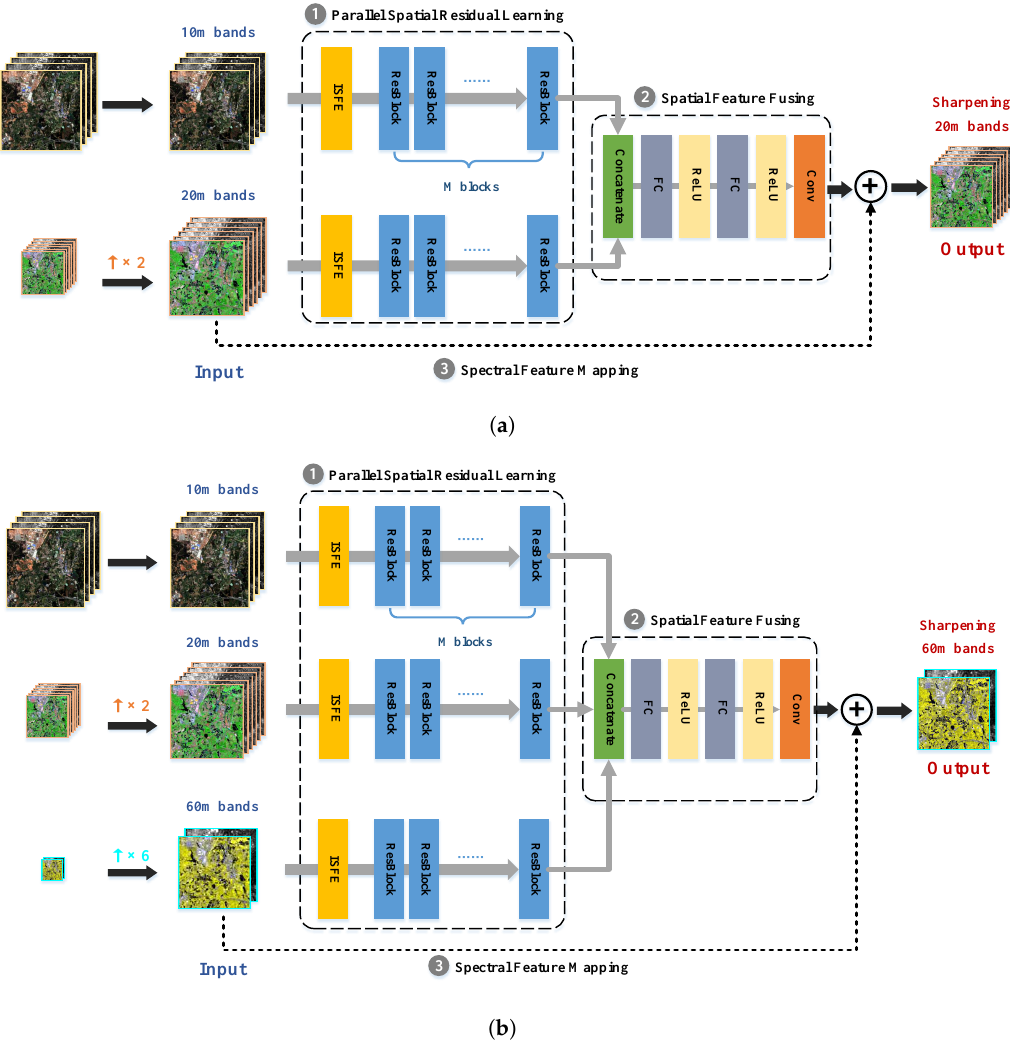
, ( b ) SPRNet 6 . The proposed networks for Sentinel-2 sharpening. The two Figure 1. ( a ) SPRNet 2 × × networks differ the inputs and outputs. SPRNet 2 enhances the 20 m bands fusing the 10 m and 20 m × bands. SPRNet 6 enhances the 60 m bands fusing the 10 m, 20 m and 60 m ×